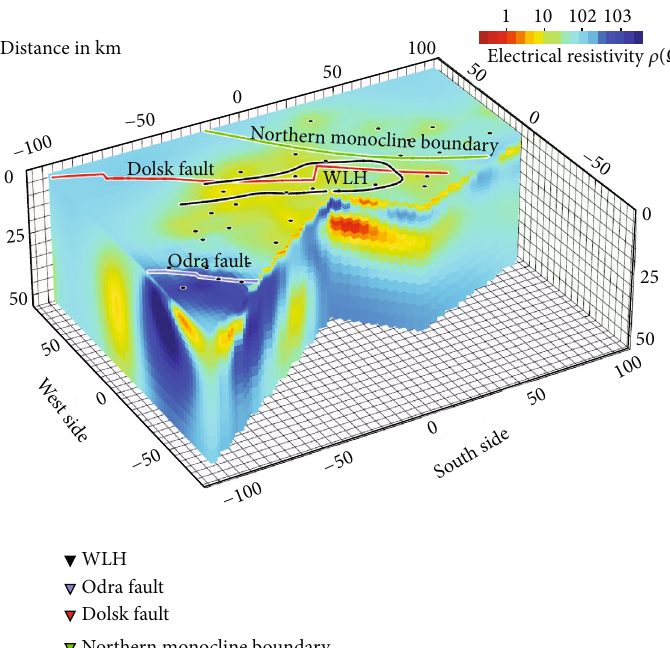
Figure 7: The fi nal 3D model of resistivity distribution with main tectonic lines and location of measuring